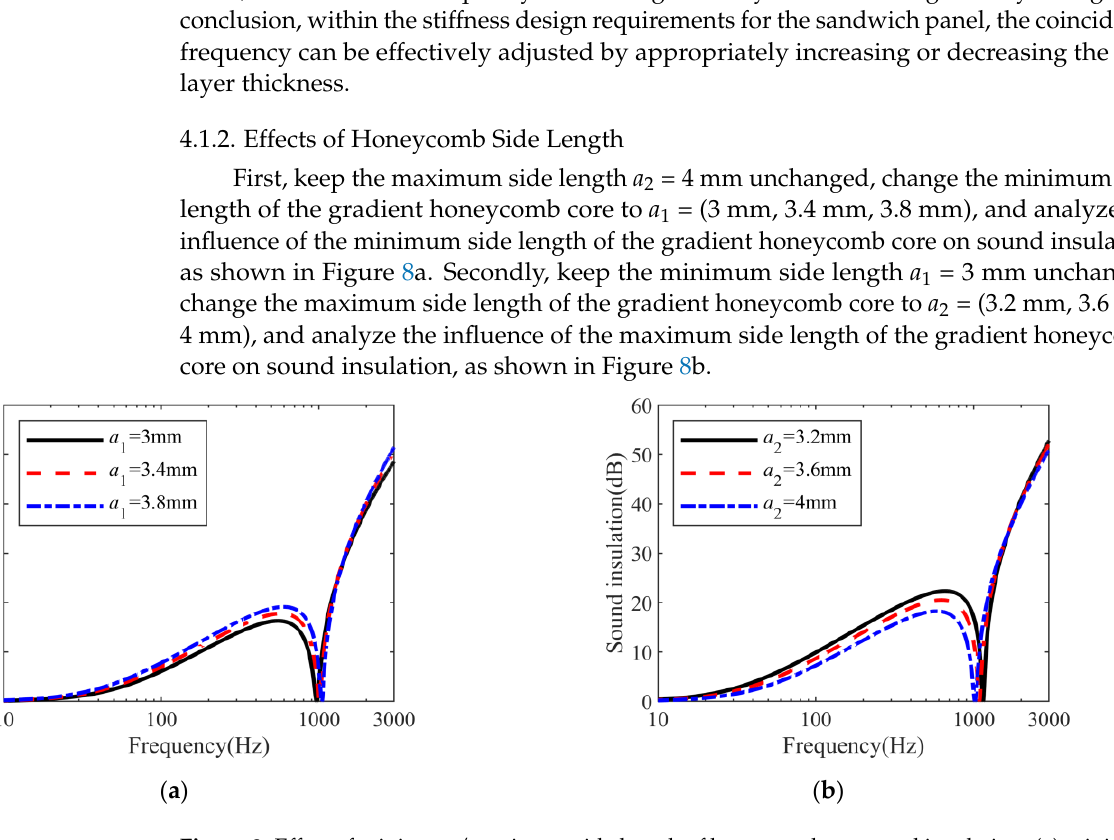
Figure 8. Effect of minimum/maximum side length of honeycomb on sound insulation: ( a ) minimum side length, ( b ) maximum side length.